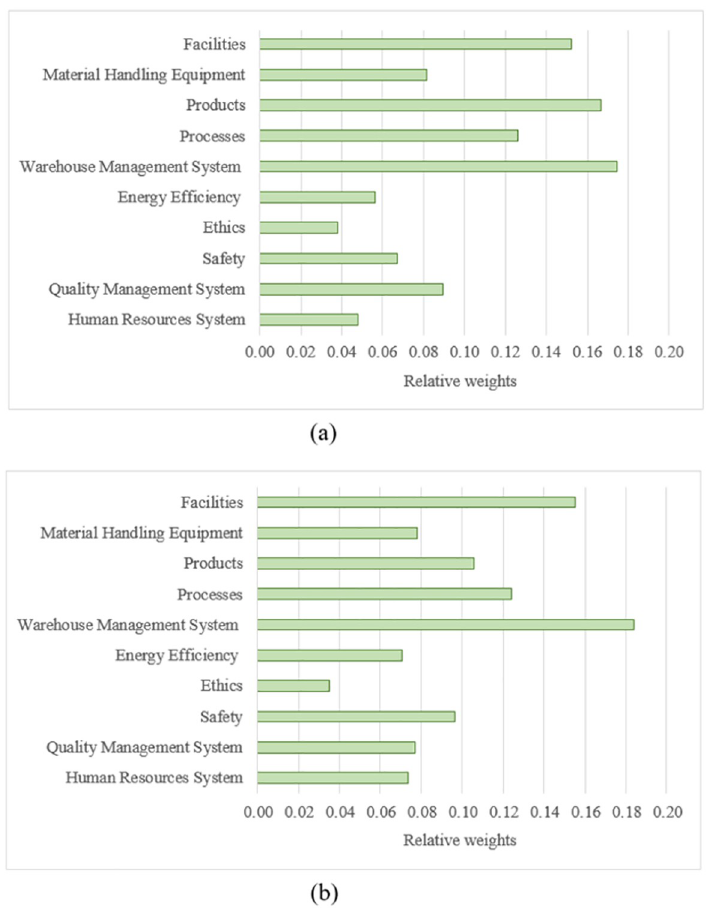
Fig 4. The relative weights of the main criteria for two product classes. (a) Class 5: Pharmaceuticals, medical and veterinary preparations; etc. and (b) Class 25: Paper and cardboard; etc.